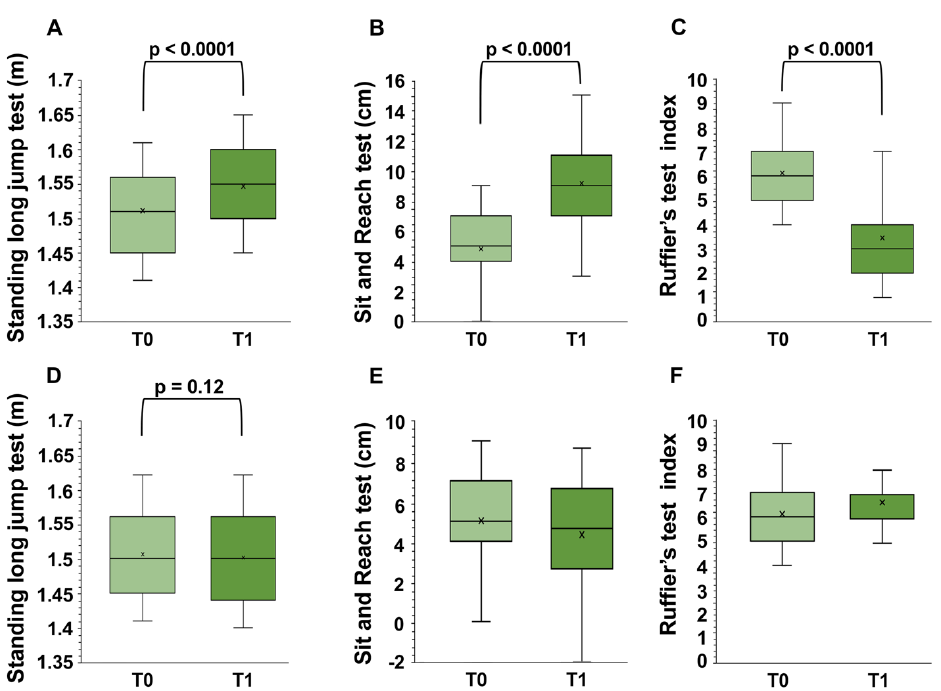
Figure 4. Differences in motor tests in the intervention ( A – C ) and control ( D – F ) groups before (T0) and after (T1) intervention obtained by two-factor repeated measures ANOVA.